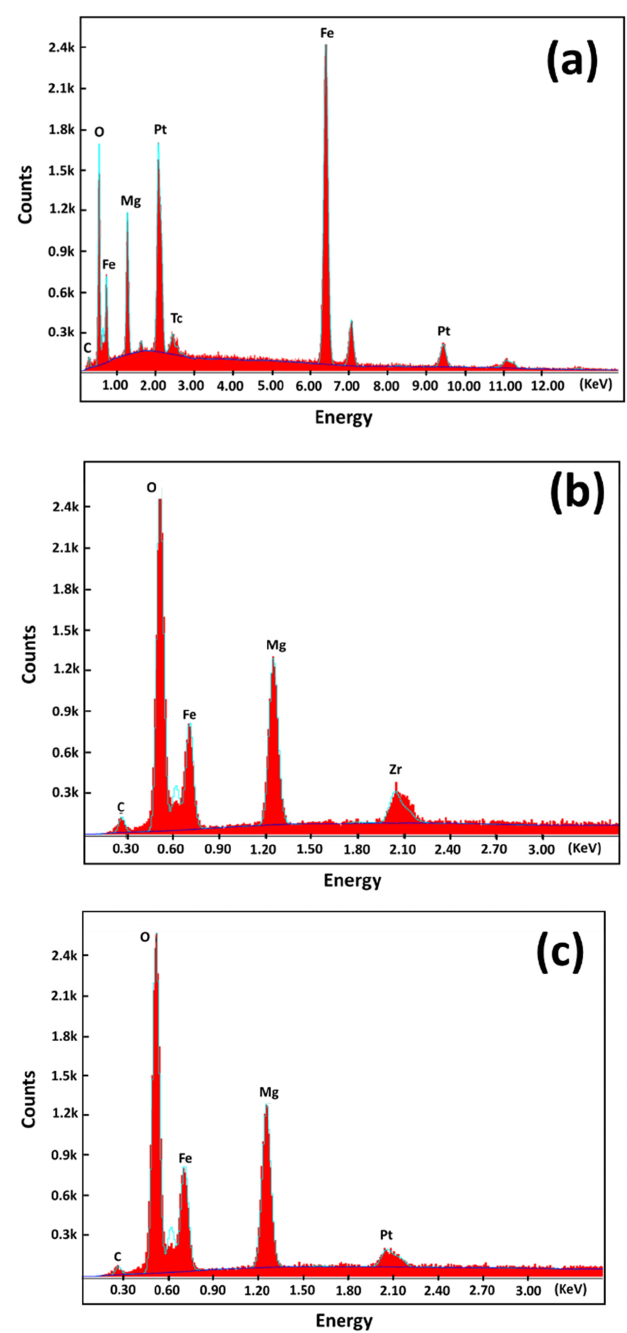
Figure 3. SEM images of MgFe 2-x O 4- δ (x = 0 ( a ), 0.05 ( b ), and 0.1 ( c )) ferrite, respectively.